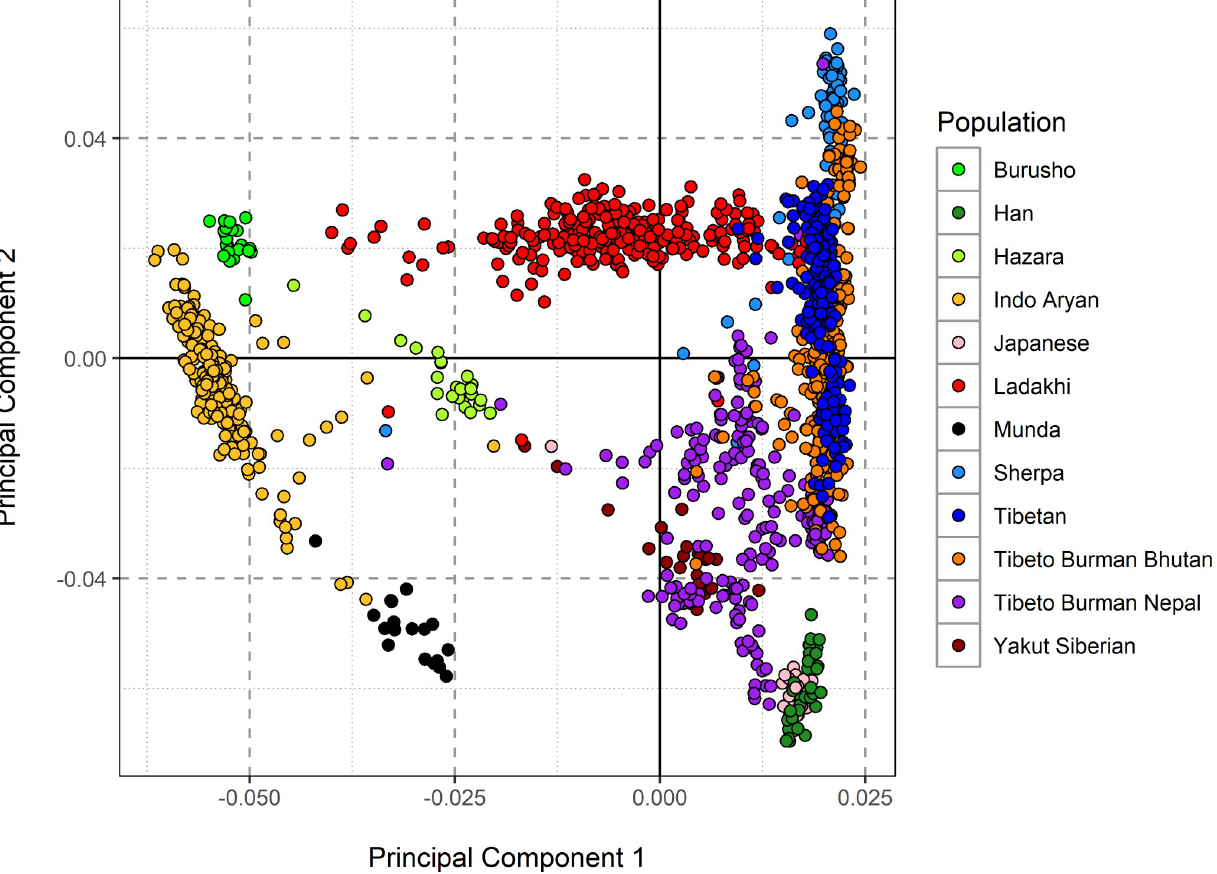
Fig 1. Principal Component Analysis (PCA) of Ladakhi population. PCA of Ladakhi and its neighboring populations are indicated in the figure legend. First and second components of PCA analysis with individual clusters labelled by different colours.